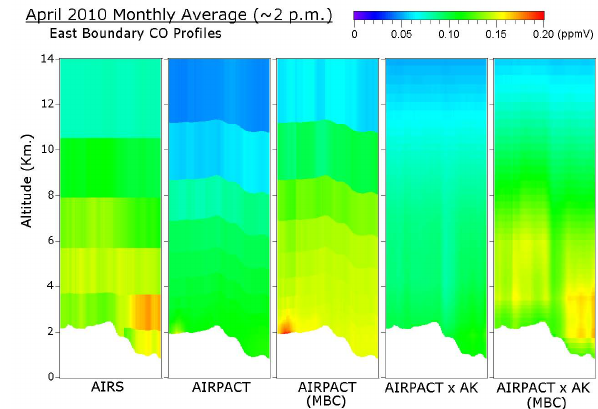
Fig. 9. April 2010 monthly average ( ∼ 02:00 p.m. PST) carbon monoxide profiles along the south border of AIRPACT-3 for (a) AIRS level-2 v5, (b) original AIRPACT-3, (c) AIRPACT-3 MBC, (d) original AIRPACT-3 convolved with the AIRS averaging kernel, and (e) AIRPACT-3 MBC convolved with the AIRS averaging ker- nel. Note that AIRPACT-3 values shown are the predicted CMAQ concentrations, and not boundary conditions themselves. For ref- erence, x-axes run from west to east: offshore northern California (left) to Salt Lake City (right).